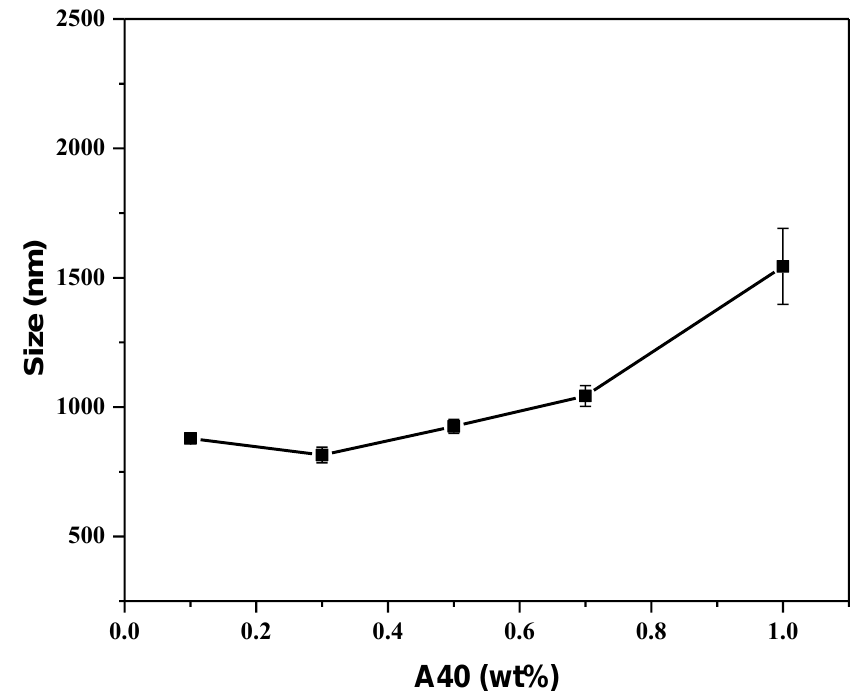
Figure 3. Size analysis for β -TCP suspension in different A40 concentrations.